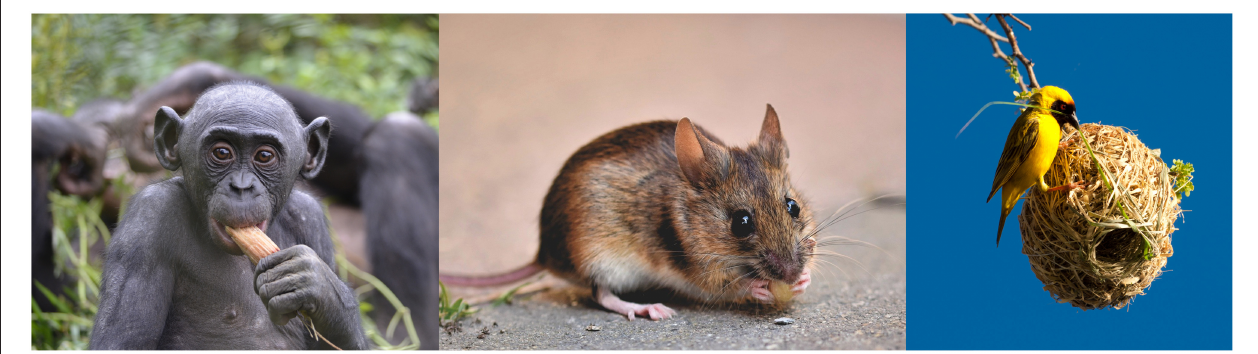
FIGURE 1 | Skilled object manipulation across three taxa. Left panel: a primate holds a piece of sugar cane with one hand. Middle panel: a mouse grasps a peanut with both hands. Right panel: a weaver bird secures fresh nest material with its bill. Image credit (left, middle, right): Christopher Krupenye; Ralph Capri; Holger Mette.